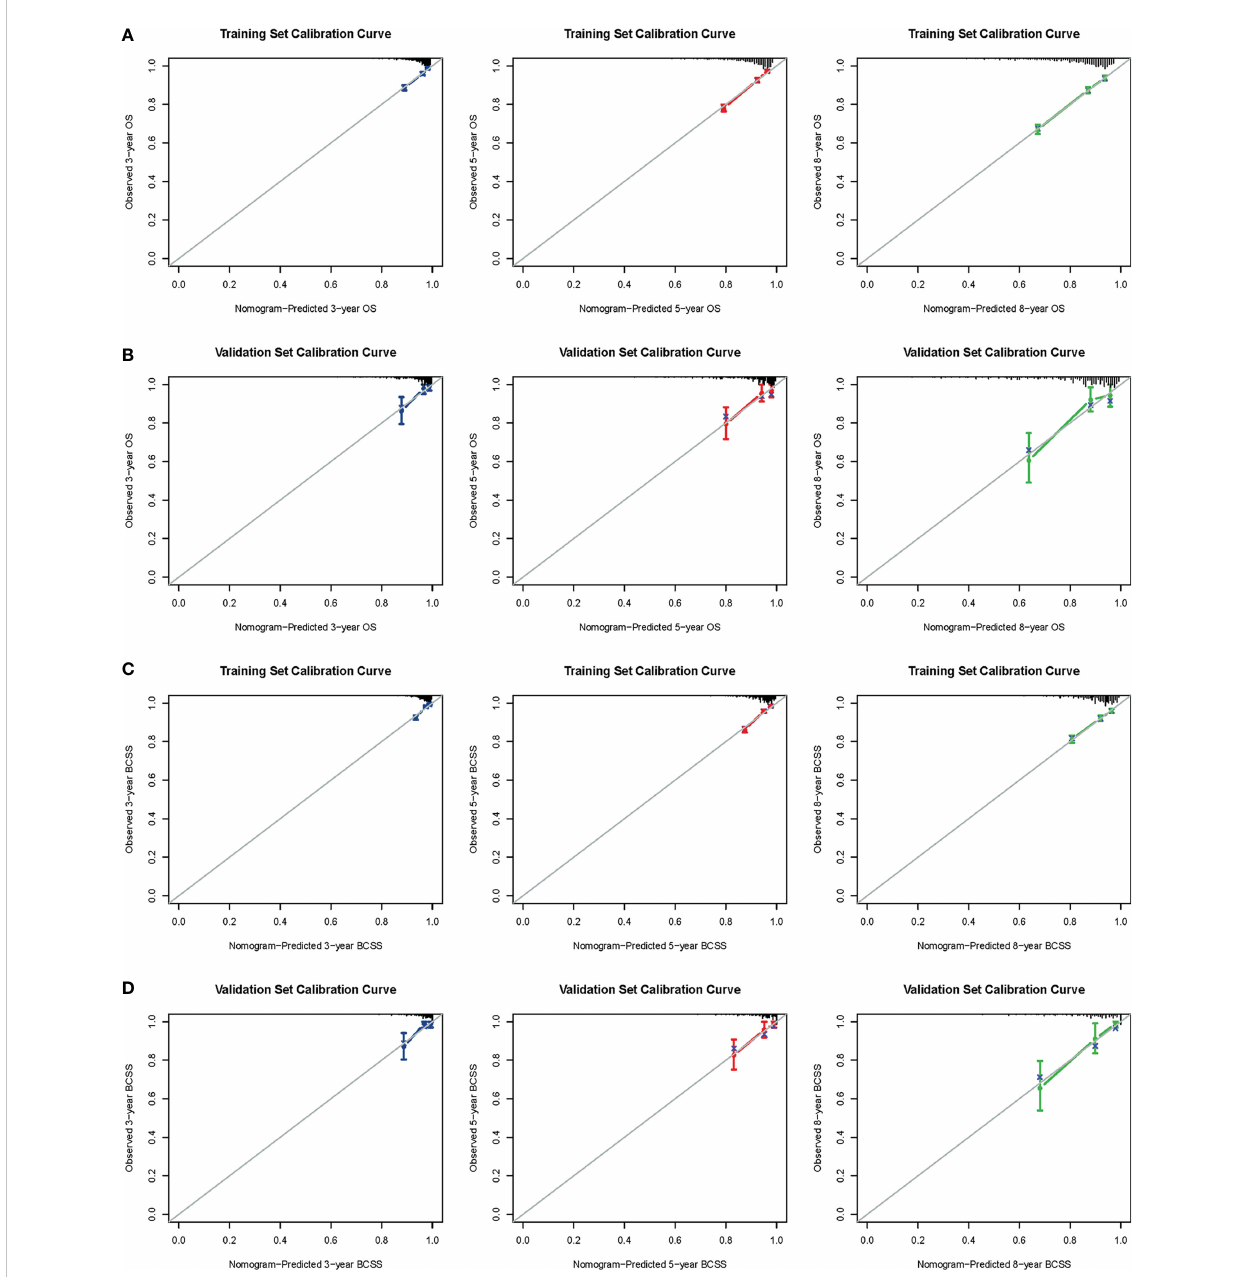
FIGURE 4 Calibration curves. 3-, 5-, and 8-year OS nomogram calibration curves for training (A) and validation cohorts (B) ; 3-, 5-, and 8-year BCSS nomogram calibration curves for training (C) and validation cohorts (D) . OS, overall survival; BCSS, breast cancer-speci fi c